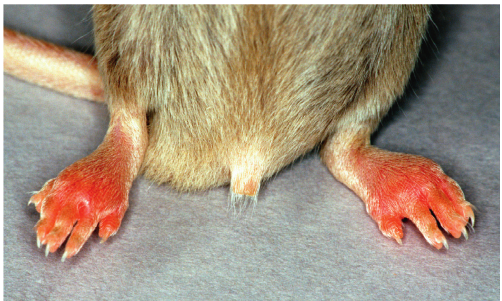
Figure 3: Arthritis induced by the IV injection of an anti-type II collagen monoclonal antibody cocktail. Arthritis in DBA/1 mice on day 8 after the IV injection of the four-clone monoclonal antibody cocktail (10mg), which recognizes the multispecies common epitope on the CB11 fragment of type II collagen. Mice developed polyarthritis in the